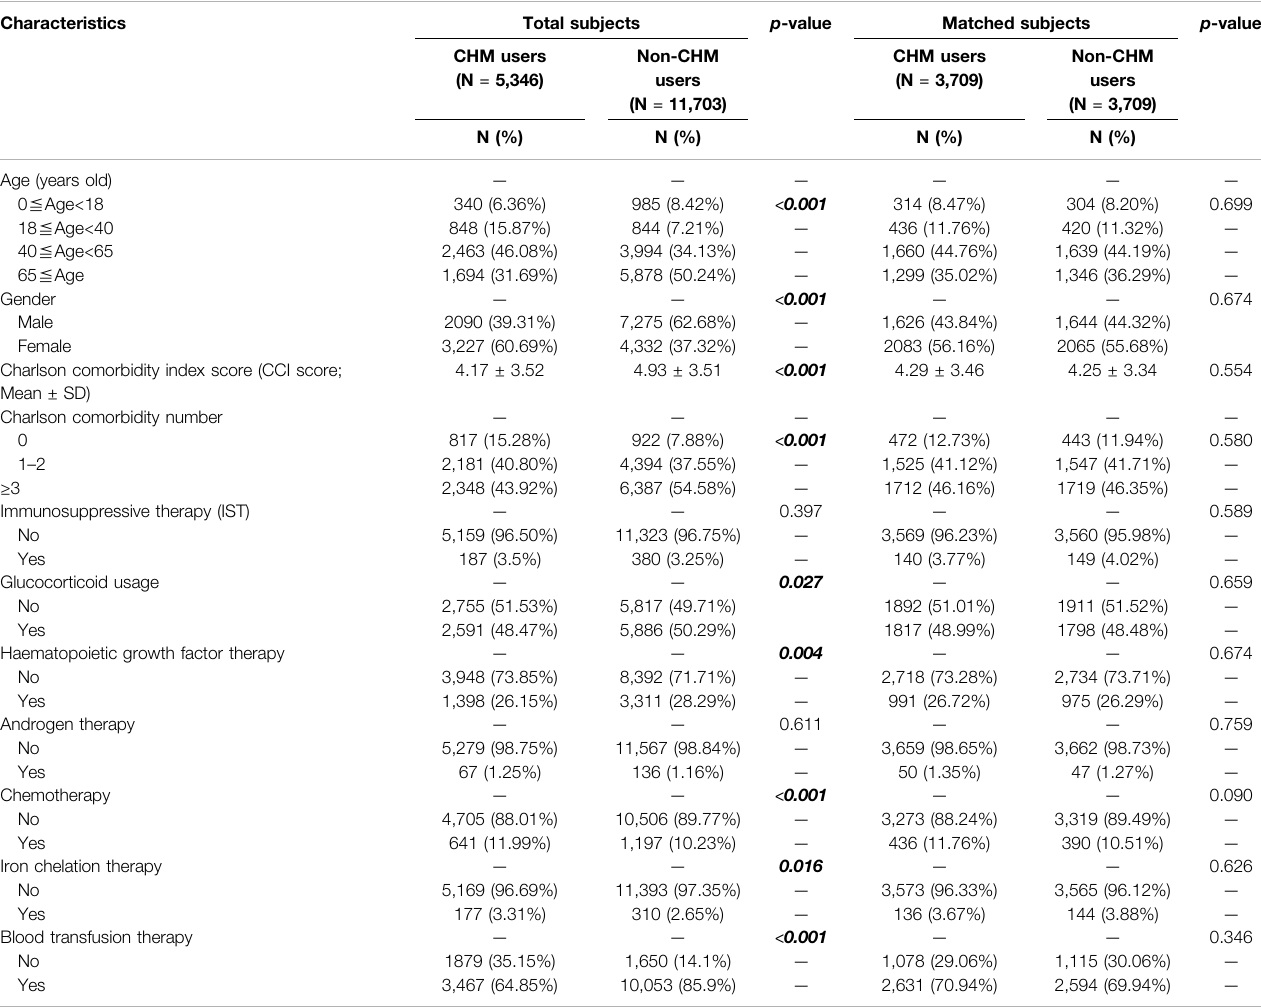
TABLE 1 | Basic characteristics of patients with aplastic anemia in Taiwan.